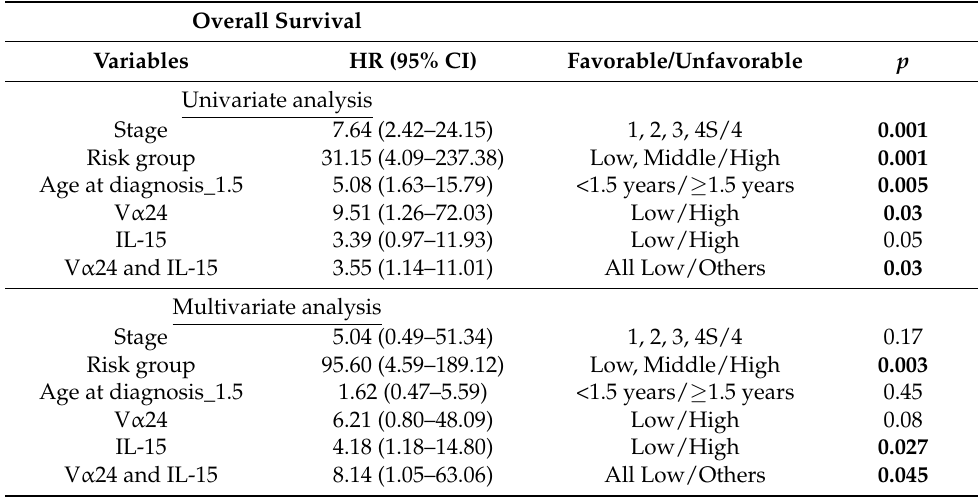
Table 2. Cox regression analyses of the various factors associated with event-free survival in NBL patients ( n = 53). Overall Survival